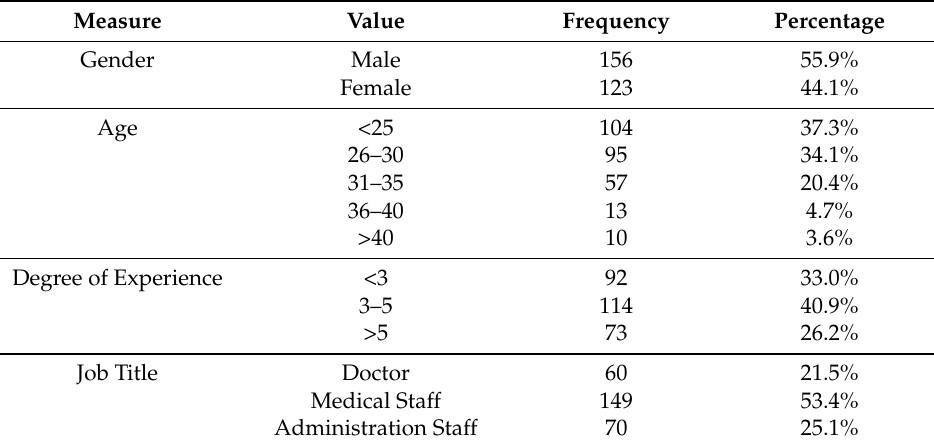
Table 1. Demographic characteristics of the respondents.